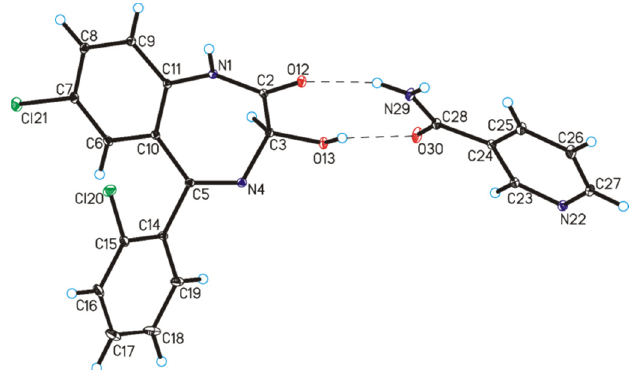
Figure 7. Molecular structure of lorazepam co-crystals with nicotinamide, showing the atom-labeling scheme (displacement ellipsoids are drawn at a 25% probability level and H atoms are shown as small spheres of arbitrary radius; hydrogen bonds are represented by dashed lines; disordered chlorobenzene ring (C14–C19 and Cl20 atoms) was omitted for clarity).